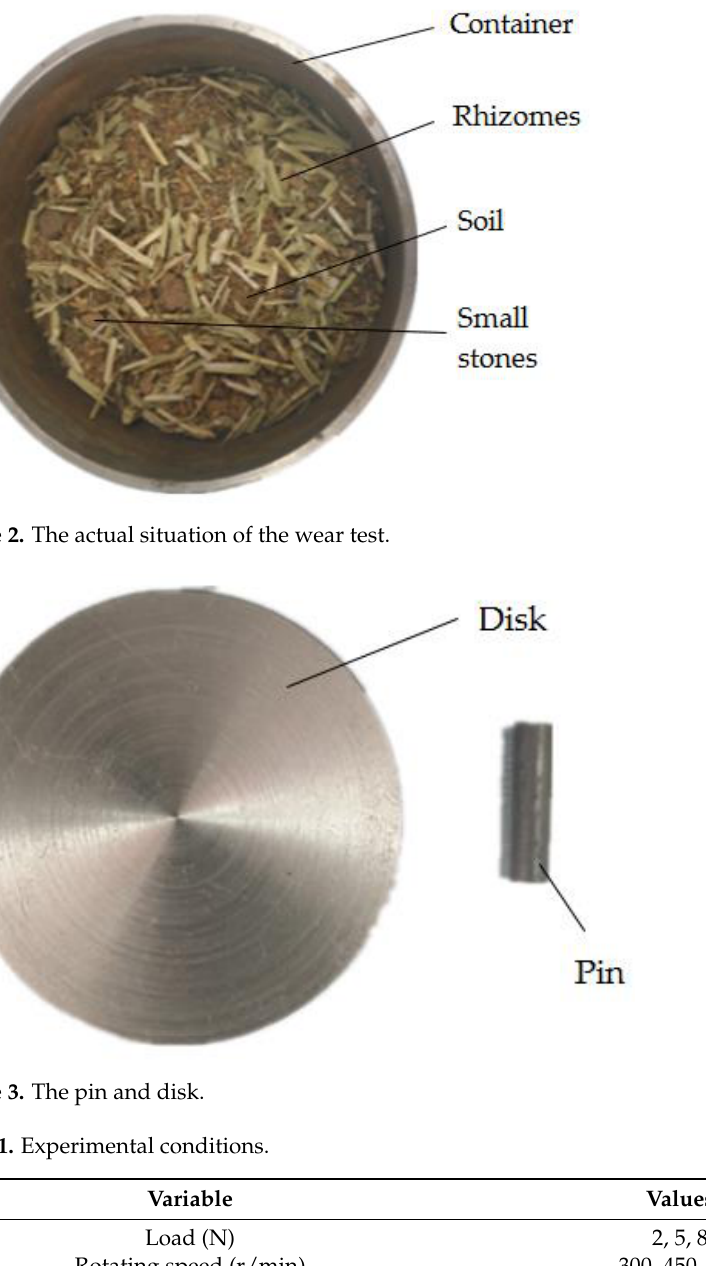
Figure 2. The actual situation of the wear test.